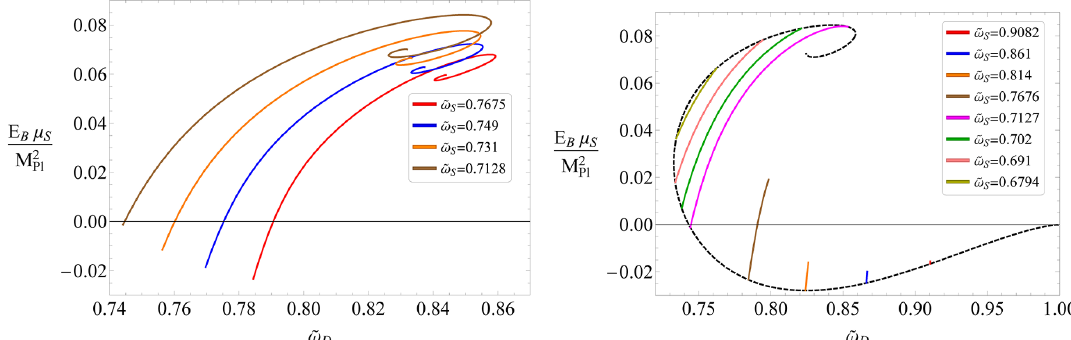
Figure 12. Left panel : the binding energy E B of the multi-branch solution family as a function of the nonsynchronized frequency ˜ ω D for several values of the scalar field frequency ˜ ω S . Right panel : same as left panel for the one-branch-A and one-branch-B solution families. The black dashed line represents the D 0 state solutions. All solutions have ˜ µ S = ˜ µ D = 1